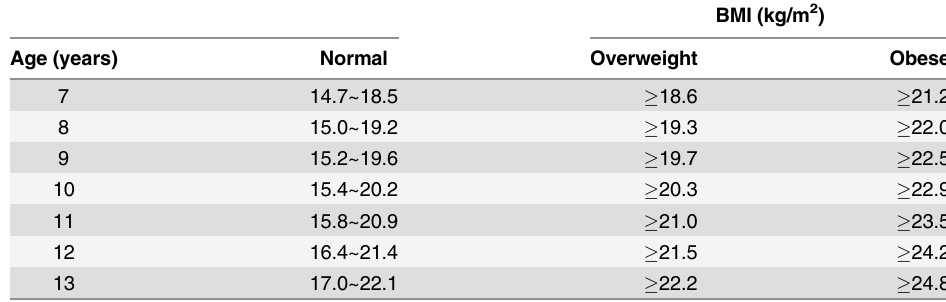
Table 1. Age- and gender-specific cutoff points for the body-mass index (BMI) for overweight and obese boys and young adolescents according to guidelines of the Department of Health,